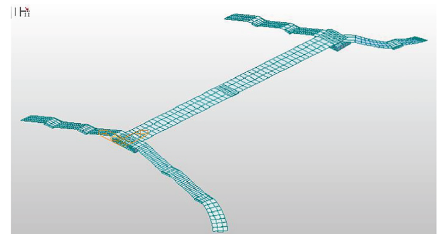
Figure 2: Finite element model of the pedestrian